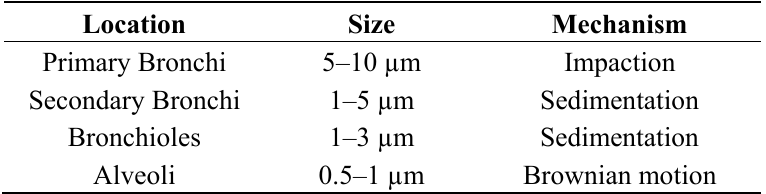
Table 1. Correlation between the areas of lung deposition, the mechanism of deposition and particle size